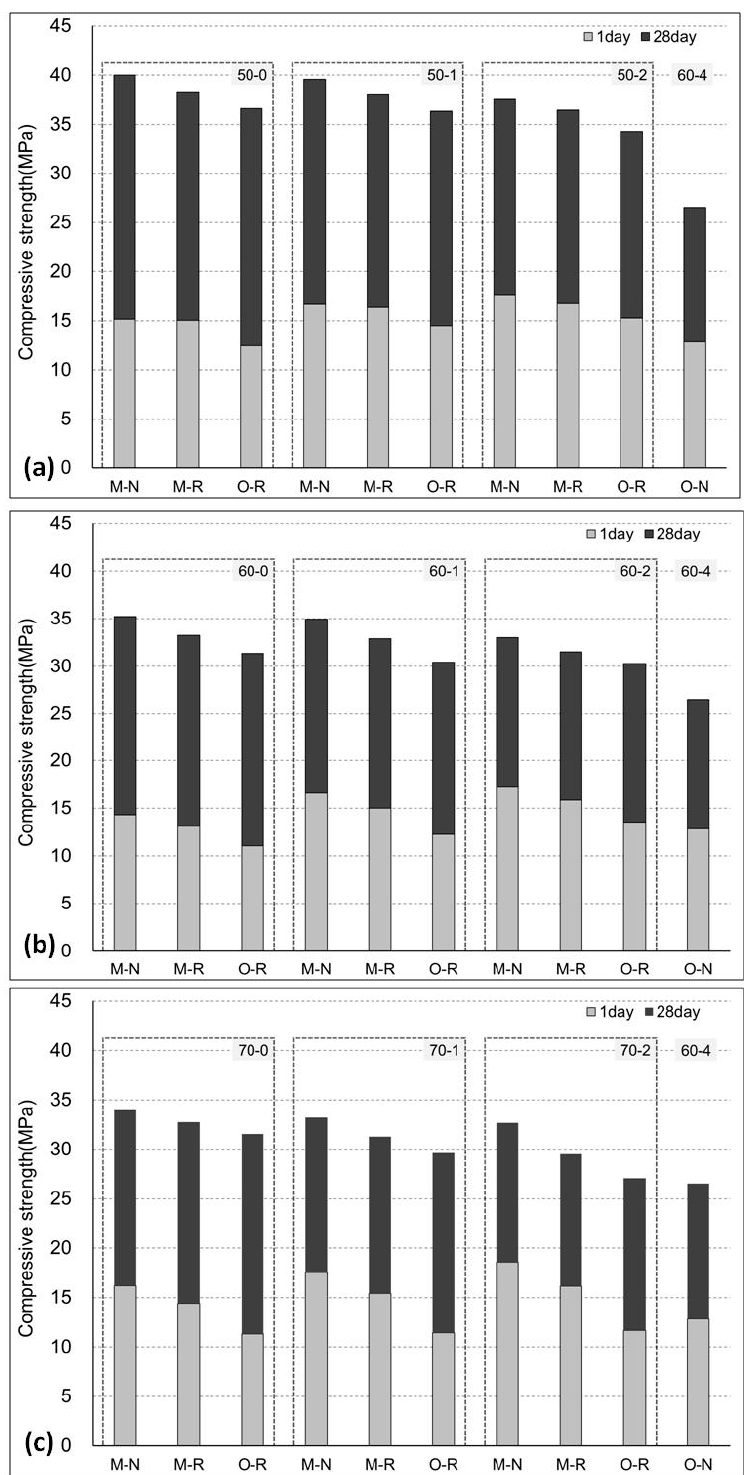
Figure 7. Comparison of the 1-day and 28-day strength of the concrete specimens with peak curing temperature of ( a ) 50 °C, ( b ) 60 °C, and ( c ) 70 °C.